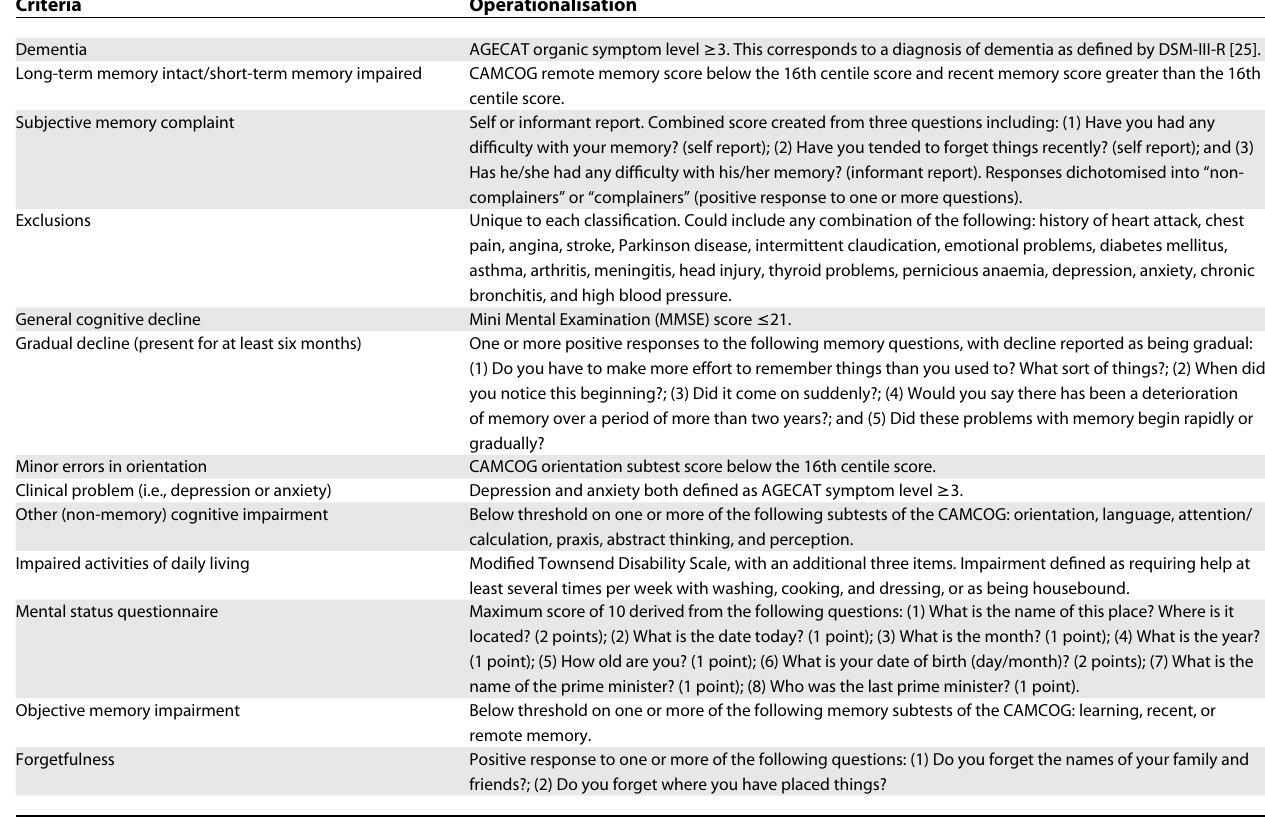
Table 1. Operationalisation of Components of Classification Systems in the Medical Research Council Cognitive